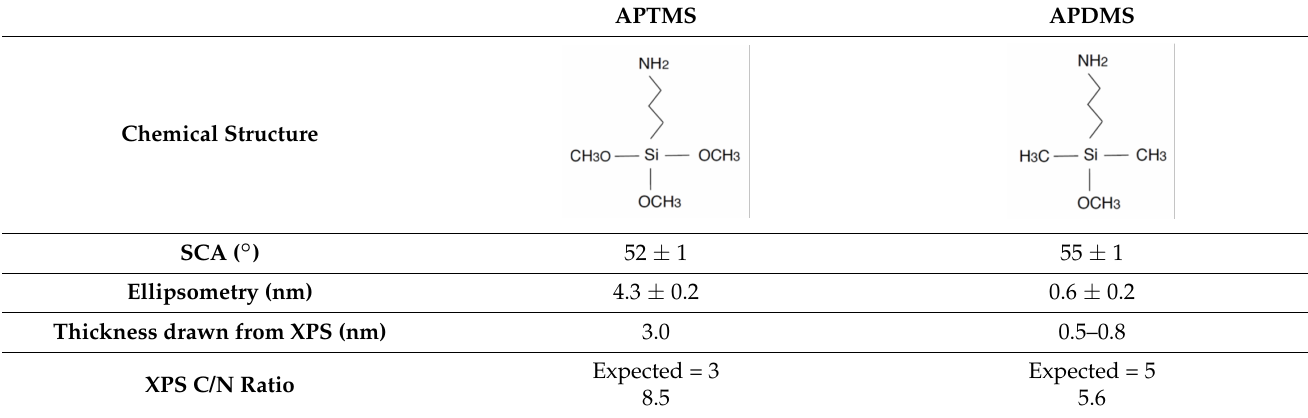
Table 1. Comparison of the structure and monolayer formation of two silanes. APDMS and